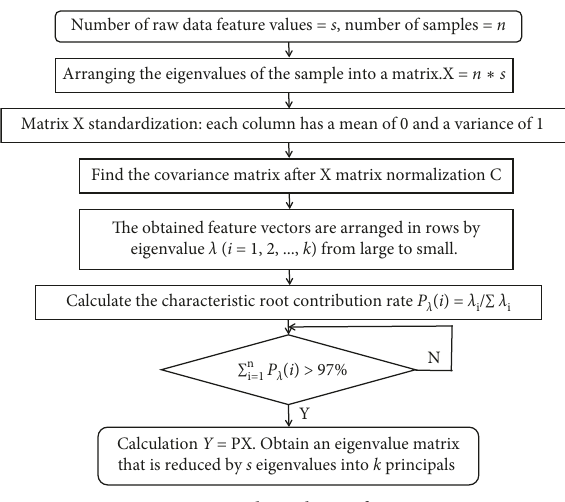
Figure 9: Flow chart of